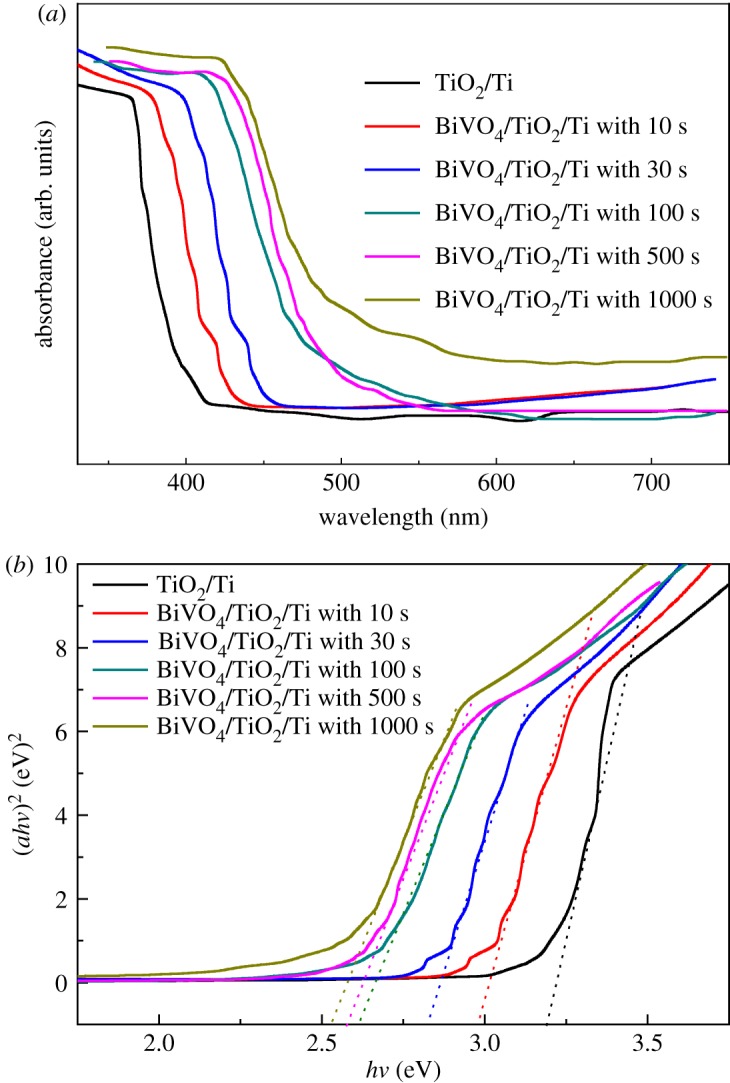
(a) UV–vis absorption spectra and (b) Tauc plot of nanoporous TiO2/Ti film and BiVO4/TiO2/Ti heterojunction films prepared with different electrodeposition times.